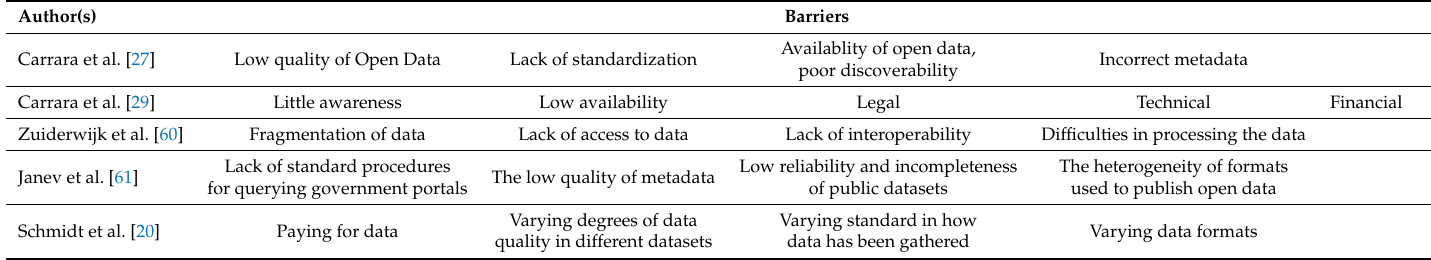
Table 3. This table represent the mentioned barriers by some authors to release and reuse open data, considering the perspective of data